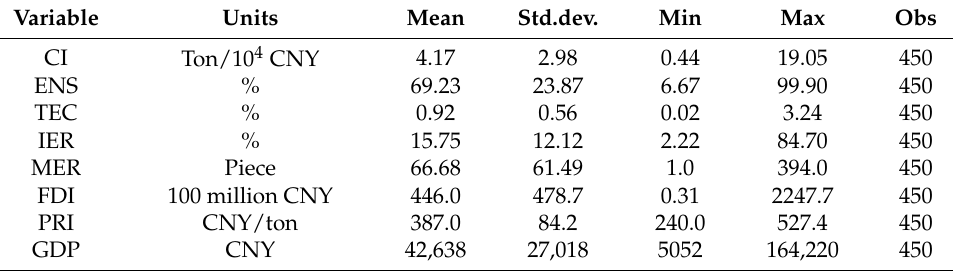
Table 2. The statistical description of